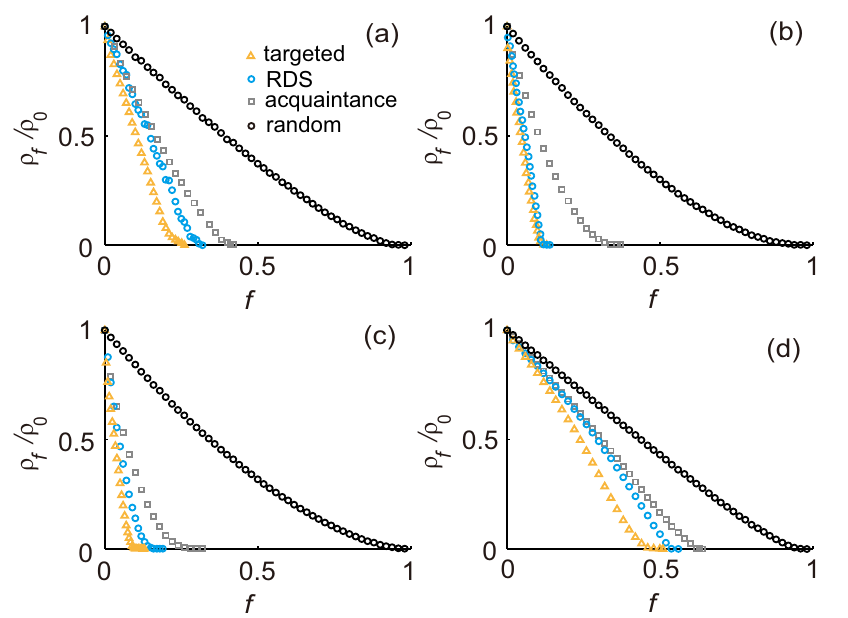
Figure 3. Reduced prevalence ρ f / ρ 0 from simulations of the SIS model in ( a ) the Advogato network, ( b ) the Brightkite network, ( c ) the Epinions network and ( d ) the MSM network with random strategy, acquaintance strategy, targeted strategy and RDS strategy, at a fixed spreading rate λ = 0.25. The prevalence is averaged over 100